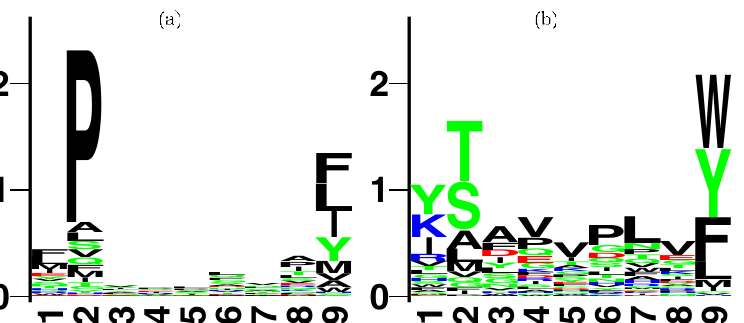
Figure 3. Binding motifs of HLA alleles with a low or high RH. The sequence logos displaying the preferences of HLA alleles with a low (A) or high (B) RH of HIV disease progression. Experimentally verified good-binding peptides for HLA-B5701 and B5801 were used to make the low RH logo (A), while the good binders of HLA-B3501 and B5301 were used for the high RH logo (B, data from www.immuneepitope.org). These sequence logos visualize i) to what extent a position in a sequence is conserved (given by the height of a bar, i.e. the information content) and ii) which amino acids are most frequently found at a particular position (the height of each amino acid in the logo is proportional to the frequency of occurrence at that position). The information content may vary between log 2 20=4.3, which is obtained if the same amino acid is always observed at a particular position, and zero, which is obtained if all amino acids occur at the same frequency at a position. Amino acids are colour coded according to their physicochemical characteristics. Neutral and polar, green; basic, blue; acidic, red; neutral and hydrophobic, black. are predicted to be associated with slow disease progression. Thirty percent of these CTL epitopes remain to be experimentally confirmed.